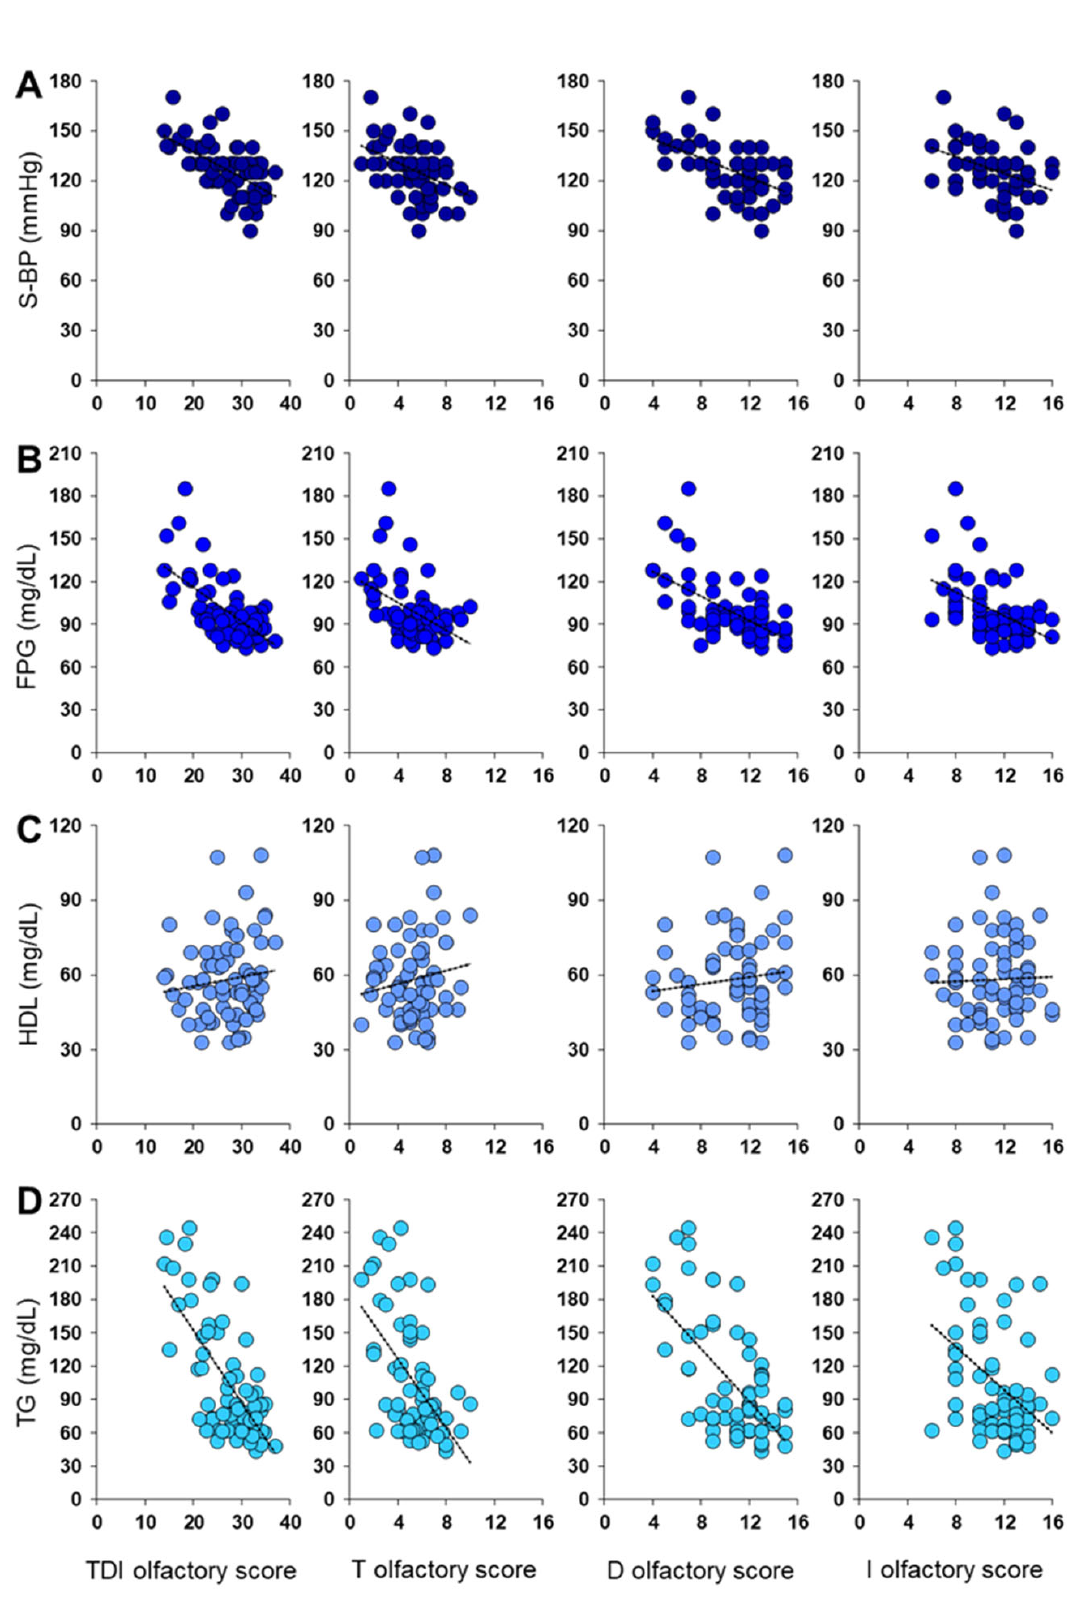
Figure 2. Correlation analysis between olfactory scores obtained by each patient and her/his ( A ) Systolic Blood Pressure (S-BP), ( B ) Fasting Plasma Glucose (FPG), ( C ) HDL levels, and ( D ) triglycerides levels (TG).